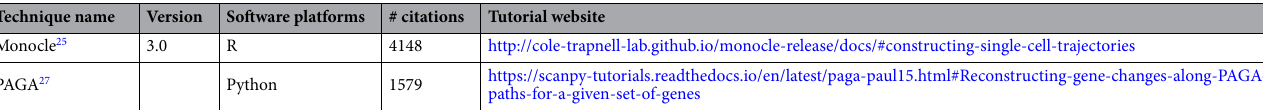
Table 4. Non-AI scRNAseq trajectory analysis